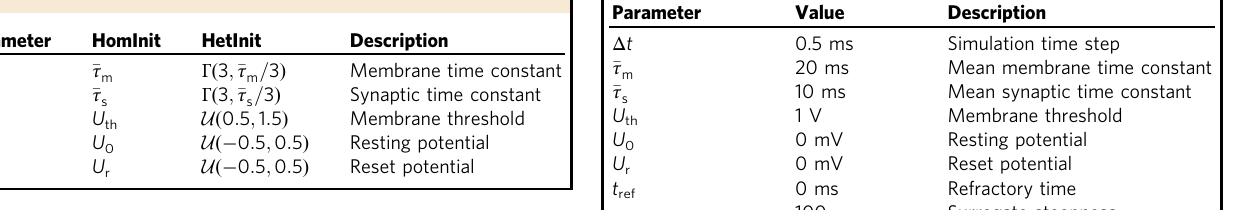
Table 2 Parameter initialisation for the different con fi gurations.